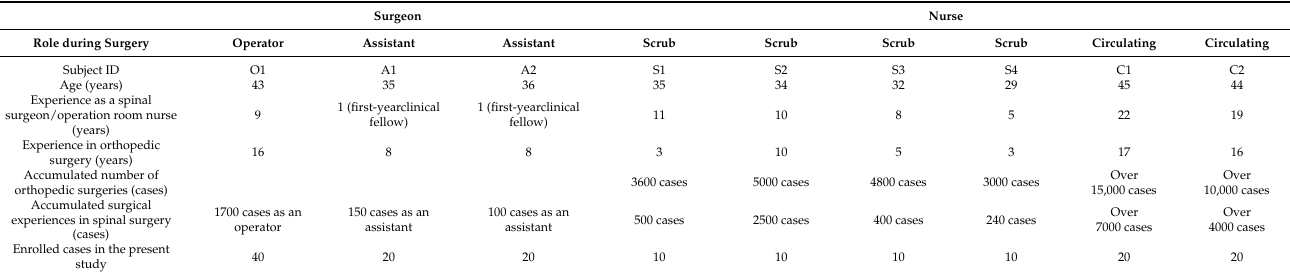
Table 1. Demographic data of enrolled study